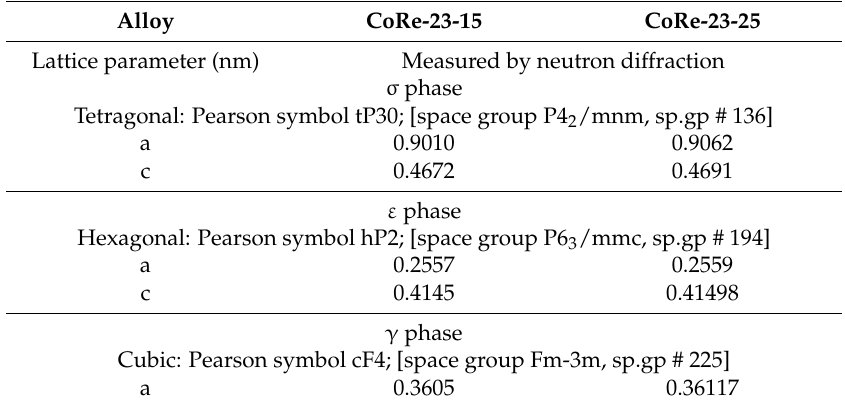
Table 2. Crystal structures of different phases present in Co-Re-Cr-Ni alloys and their lattice parameter values measured by neutron diffraction [7].